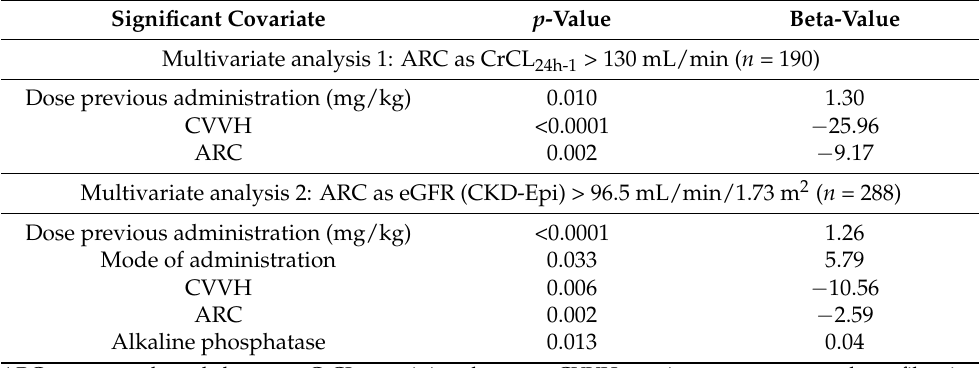
Table 3. Significant covariates based on multivariate analyses using generalized estimating equations.